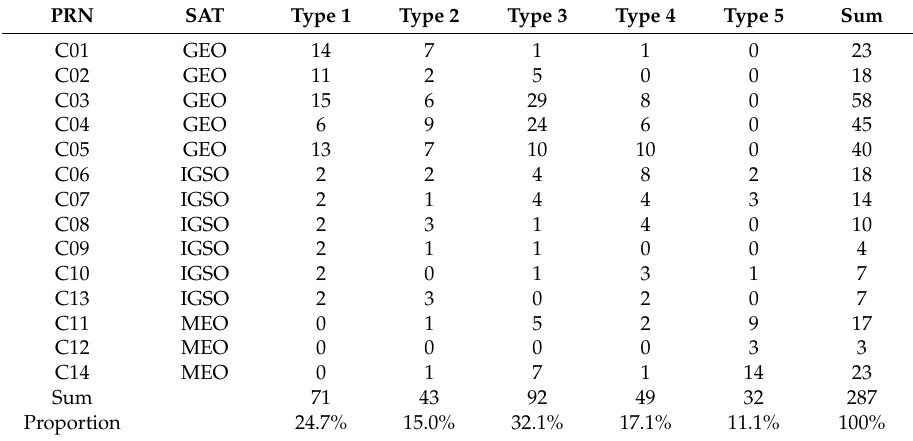
Table 1. Occurrence of different types of unhealthy states for different satellites.